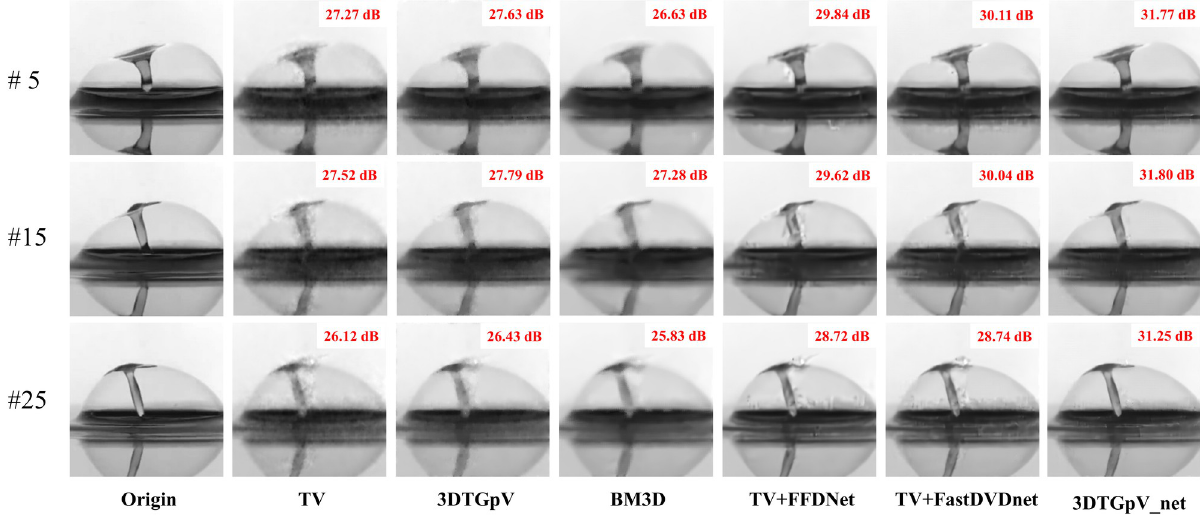
Fig 4. The 5 th , 15 th and 25 th reconstructed frames based on simulated datasets: Drop.